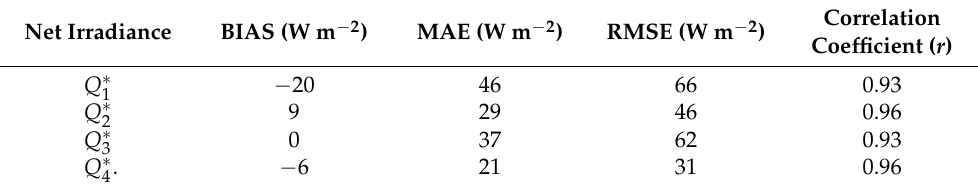
Table 16. Statistical errors and coefficients of correlation for Q ∗ Observatory Debrecen for the 3-year time period from 2008 to 2010. The applied parameterizations are presented in Figure 8.